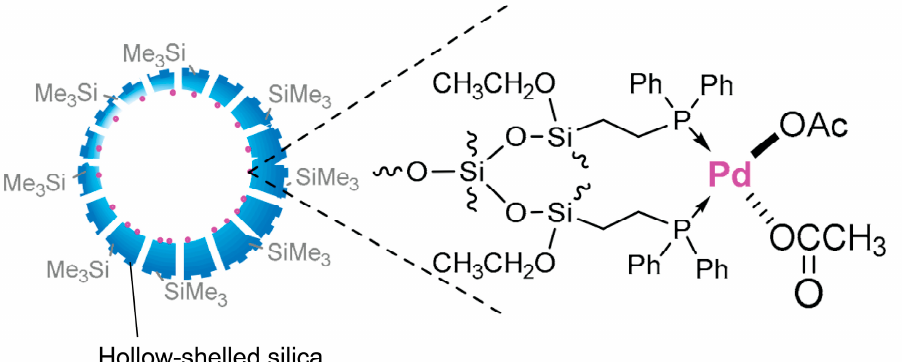
Figure 7. Hollow-shelled silica-supported palladium catalyst adapted under a Creative Commons Attribution 4.0 License from [46] (p. 3) © 2021 Abdulelah Taher Ali Mohammed, Lijian Wang, Rong- hua Jin, Guohua Liu, and Chunxia Tan.